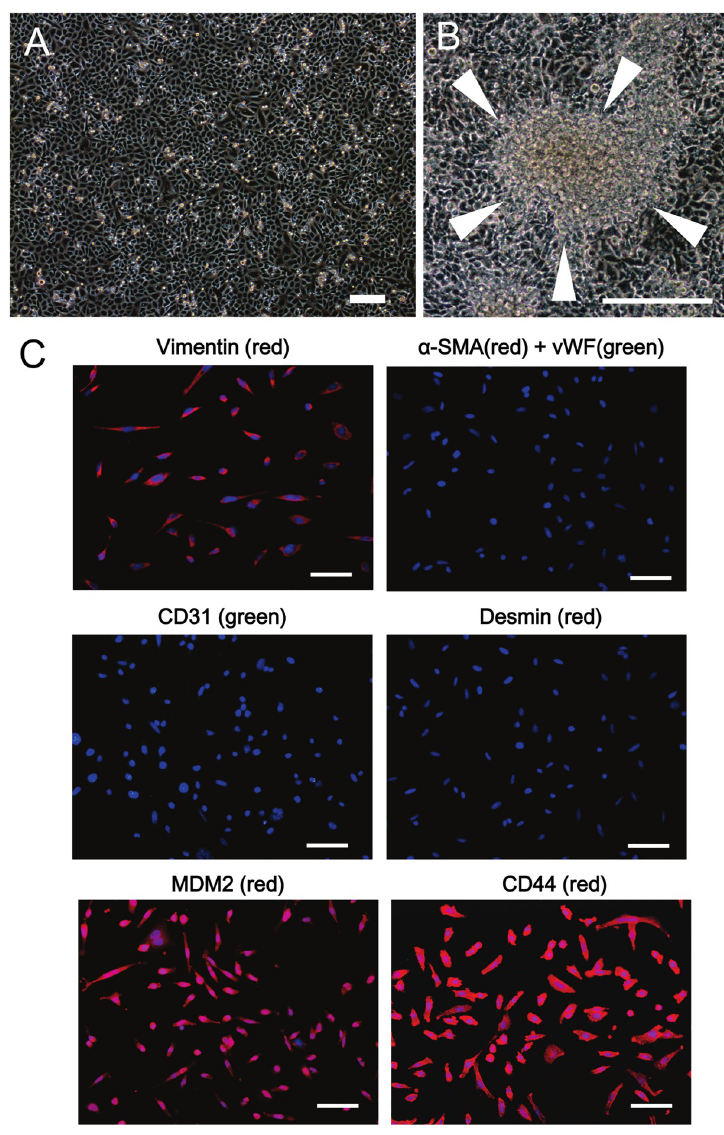
Fig 2. Characteristics of PIS-1 cells in vitro . (A) PIS-1 cells present as small and spindle-shaped cells microscopically. Scale bar, 200 μ m. (B) Transformed foci of PIS-1. Scale bar, 300 μ m. (C) Immunocytochemistry shows that PIS-1 cells were diffusely positive for vimentin, murine double minute 2 (MDM2), and CD44, and negative for α -smooth muscle actin (SMA), von Willebrand factor (vWF), CD31, and desmin. Scale bars, 50 μ m. Nuclei stained with DAPI are represented by